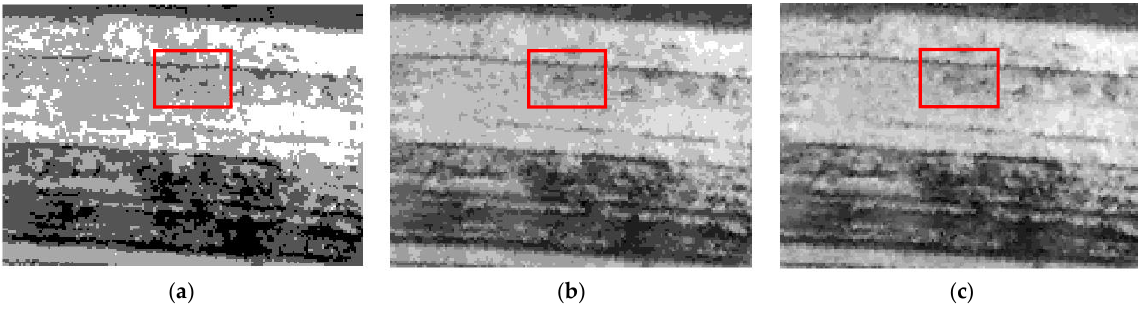
Figure 6. Comparison of gray level with 8 ( a ), 16 ( b ), and 32 ( c ) levels in GF-1 PMS images.